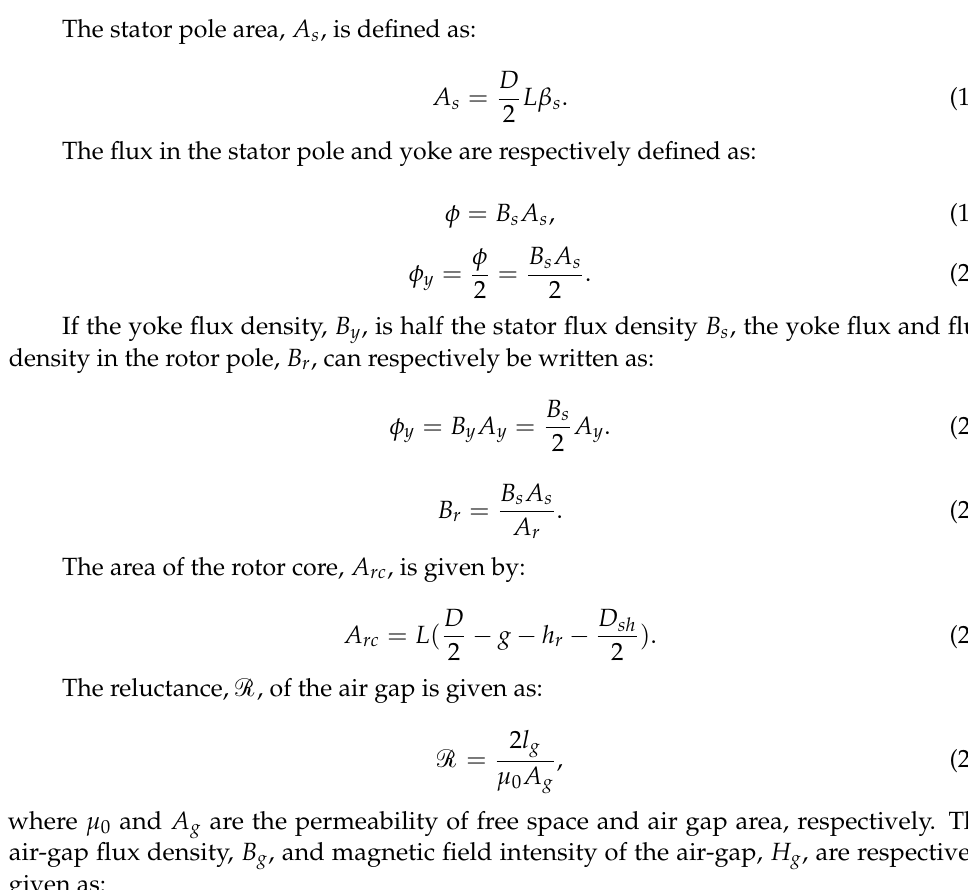
Figure 2. Magnetic flux and field distributions of the SRM model showing maximum flux density of 2.03 T around the poles of the